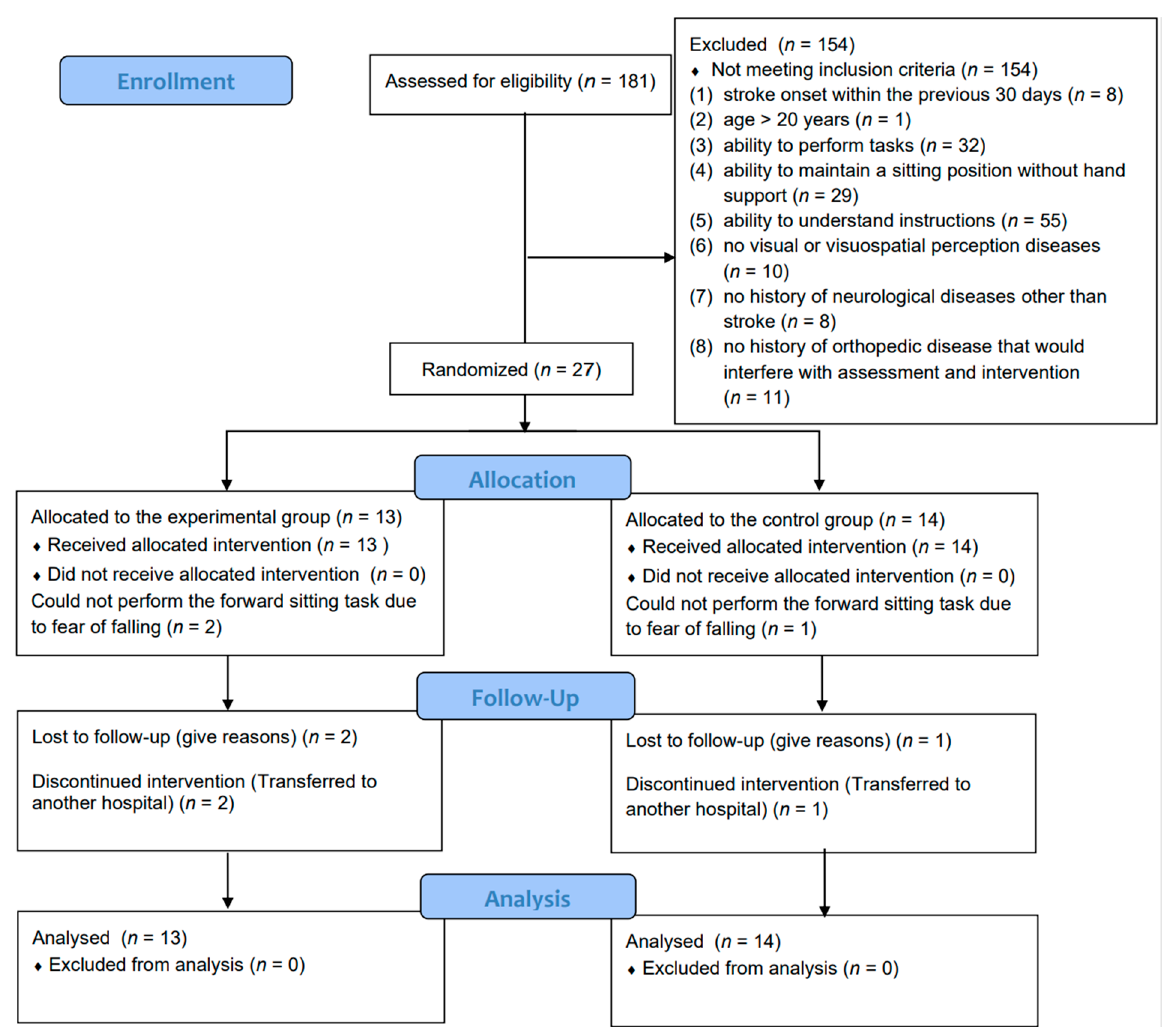
Figure 4. Flow diagram used for the selection of participants for this study.